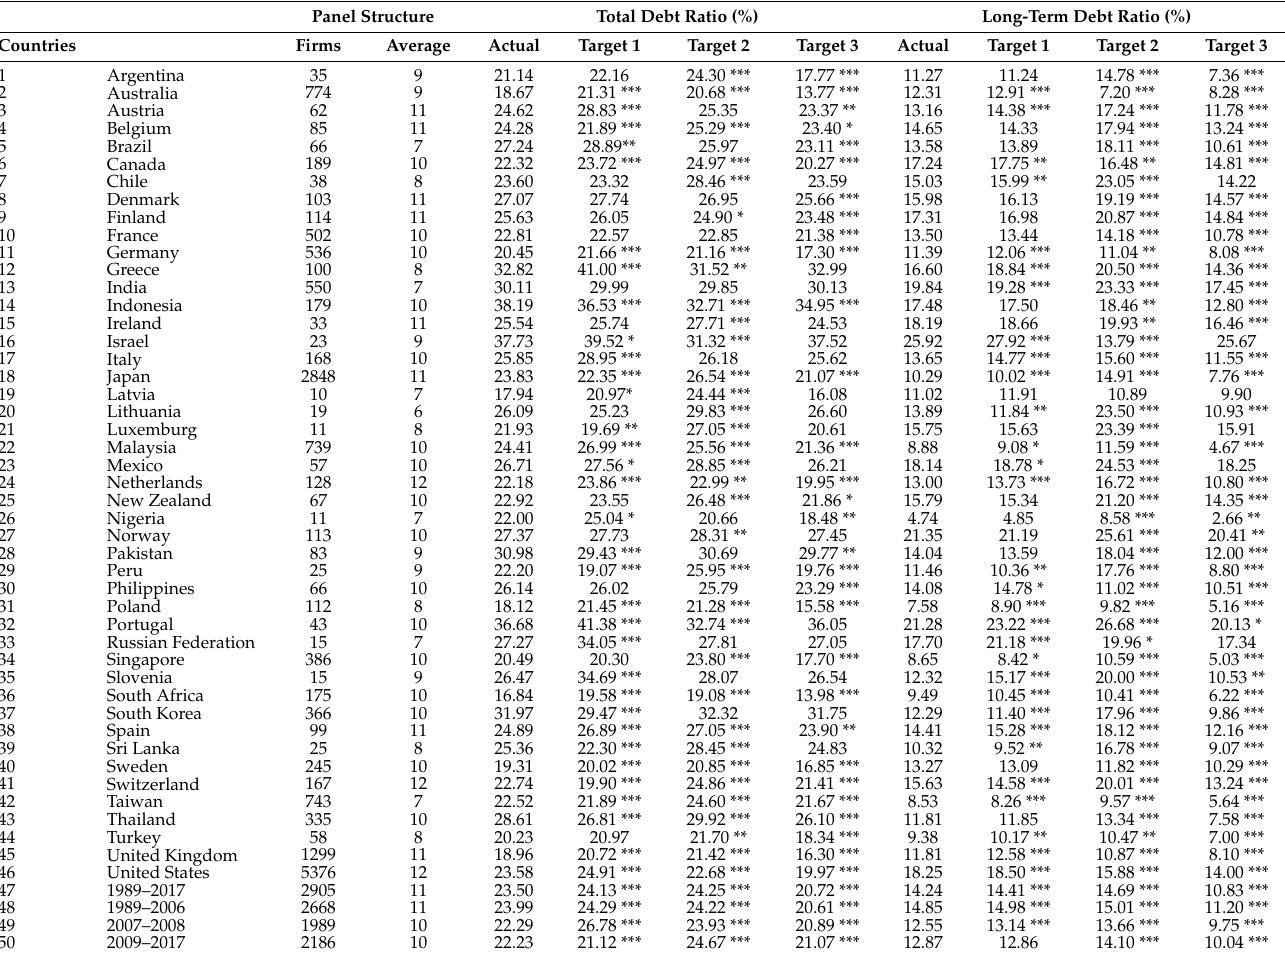
Table 3. Actual and target capital